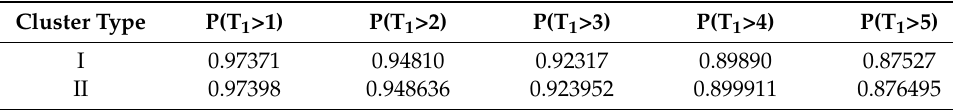
Table 25. The calculated P ( T 1 > t ) in cluster type I and